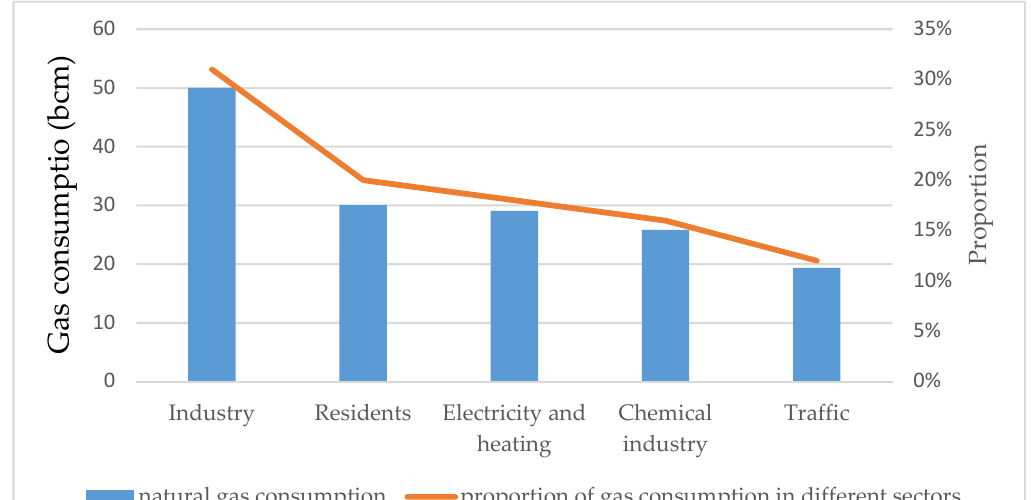
Figure 9. China’s natural gas consumption structure.